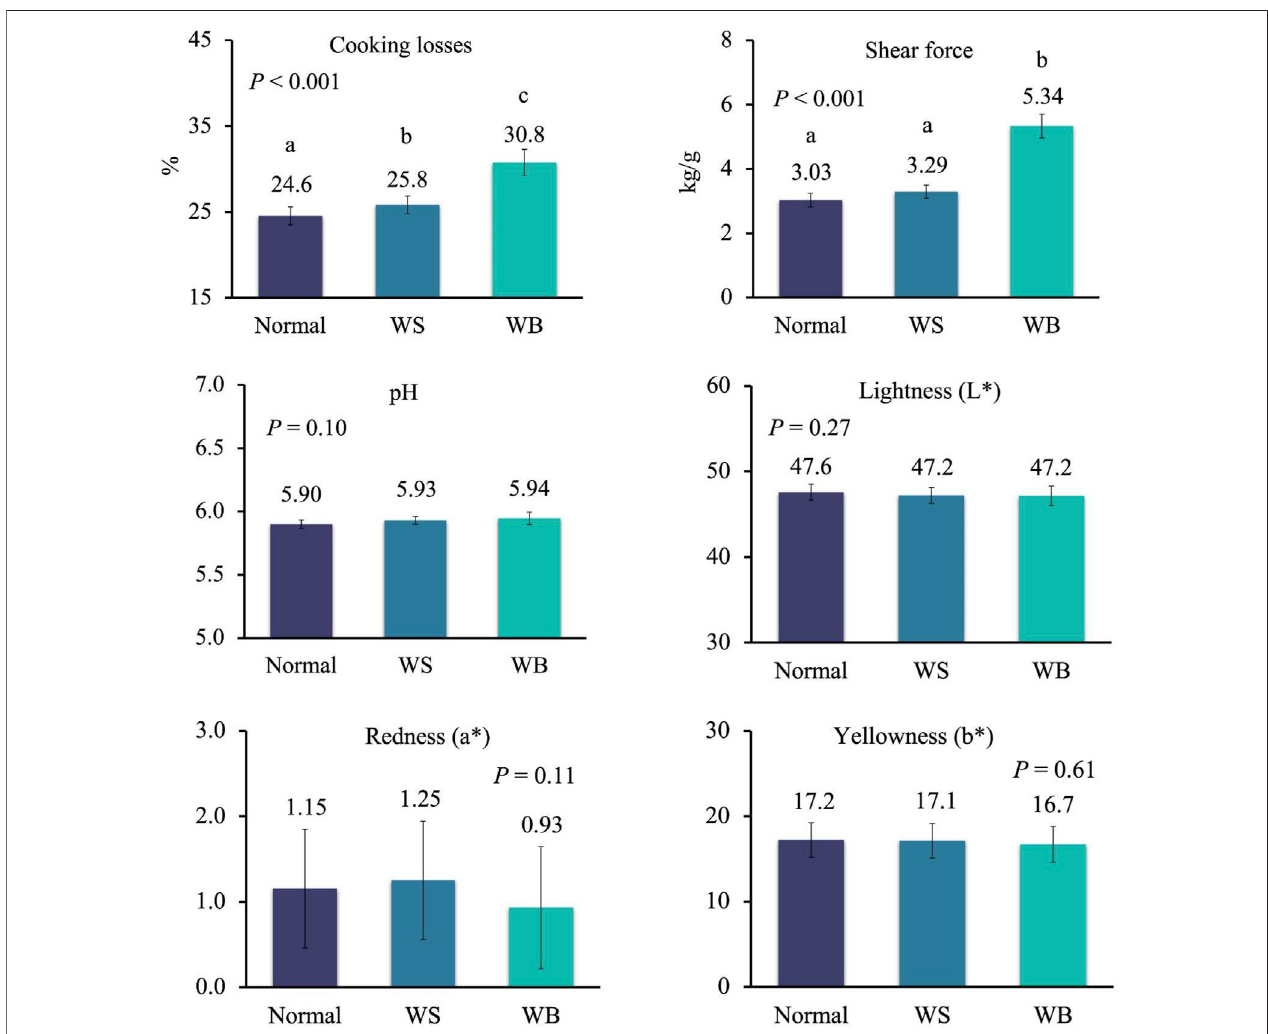
FIGURE 3 | Meat quality in normal breasts and in breasts affected by white striping (WS) and wooden breast (WB) of male broiler chickens (samples with only one myopathy). Data are presented as LS means ± standard error. Different letters above bars indicate signi fi cant differences between LS means [Number of chickens per group available in Supplementary Table S2